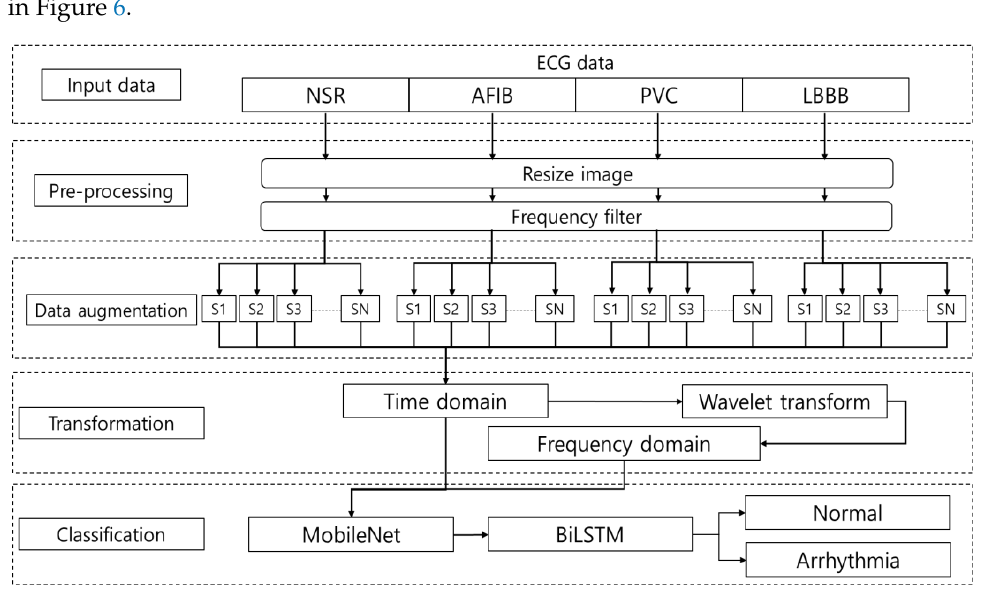
Figure 6. Diagram of the proposed algorithm. The input data consisted of four classes, and a MATLAB-based digital filter was used for preprocessing. The matching pursuit algorithm was used for data augmentation. MobileNetV2-BiLSTM was applied in the data classification process. The data ratio was the highest with 283 NSR data and the lowest with 103 LBBB data.